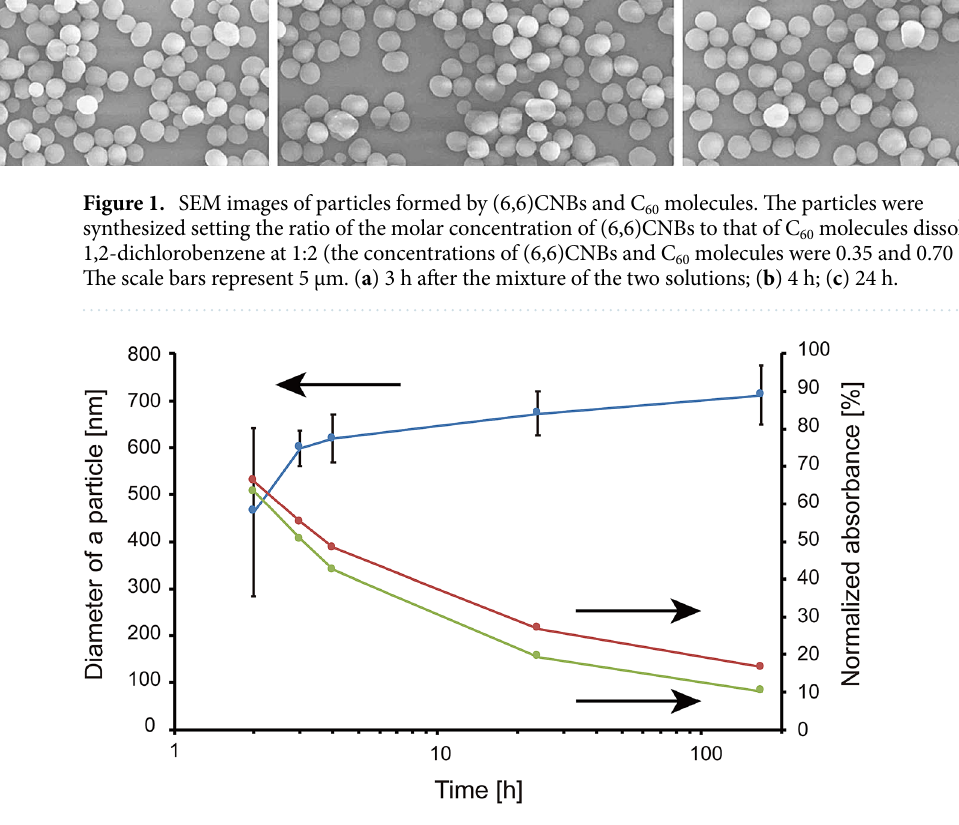
Figure 2. Time variation of the diameter of a particle and the peaks’ intensities of the absorption spectra corresponding to (6,6)CNBs and C 60 molecules dissolved in 1,2-dichlorobenzene. The ratio of the molar concentration of (6,6)CNBs to that of C 60 molecules is 1:2. Dotted red line—absorbance of 318 nm; dotted green line—absorbance of 329 nm; dotted blue line—average diameter of a